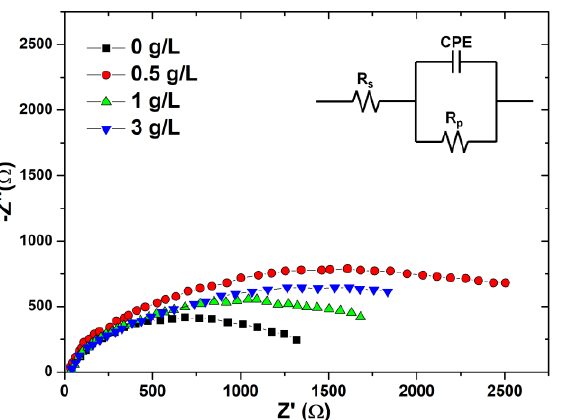
Figure 3. Nyquist plot of the Ni-W alloy and Ni-W/B composite coatings with varying boron concentrations (0, 0.5, 1, and 3 g/L).